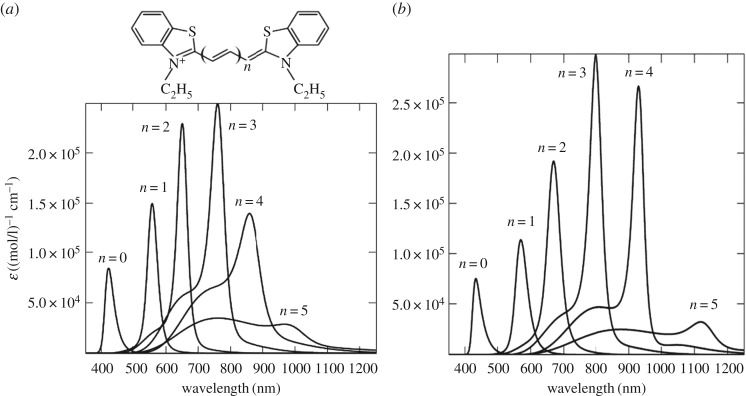
Theoretical dependence of optical absorption of an ideal polymethine dye (thiapolymethinecyanine) [5] on the polymethine chain length 2(n + 2)d, where d are certain roughly equal bond lengths in the chain. In (a), the absorption bands are computed using equations (2.12)–(2.30) and (2.34) with η ≤ 1 instead of the Gamow tunnel factor [3–6,12,13] when fitting them to experimental data of Brooker and co-workers (figure 5a) in terms of the wavelength λmax, extinction εmax, and half-width w1/2 with a high degree of accuracy. We used the ‘dye + environment’ system parameters [5] q = e, where e is the electron charge, m = me, ω = 5 × 1013 s−1, d = 0.14 nm, nref = 1.33; for n = 0,1,2,3,4,5 we respectively have J1 = (5.63, 5.40, 4.25, 3.90, 3.74, 3.40) eV, J1−J2 = (1.71, 1.31, 1.11, 0.90, 0.74, 0.40) eV, E = (0.245, 0.248, 0.256, 0.275, 0.297, 0.496) eV, and γ = (0.402, 0.205, 0.139, 0.120, 0.129, 0.131) eV; the factor η = 1 for n = 0,1,2,3 and η = 0.55,0.1 respectively for n = 4,5 (also see the caption to figure 5 above); T = 298 K. In (b), Eright = 0.8E and γright=(0.402,0.205×1.2, 0.139×1.2,0.120/1.1,0.129/1.8,0.131/1.5), the other parameters are the same as in (a).